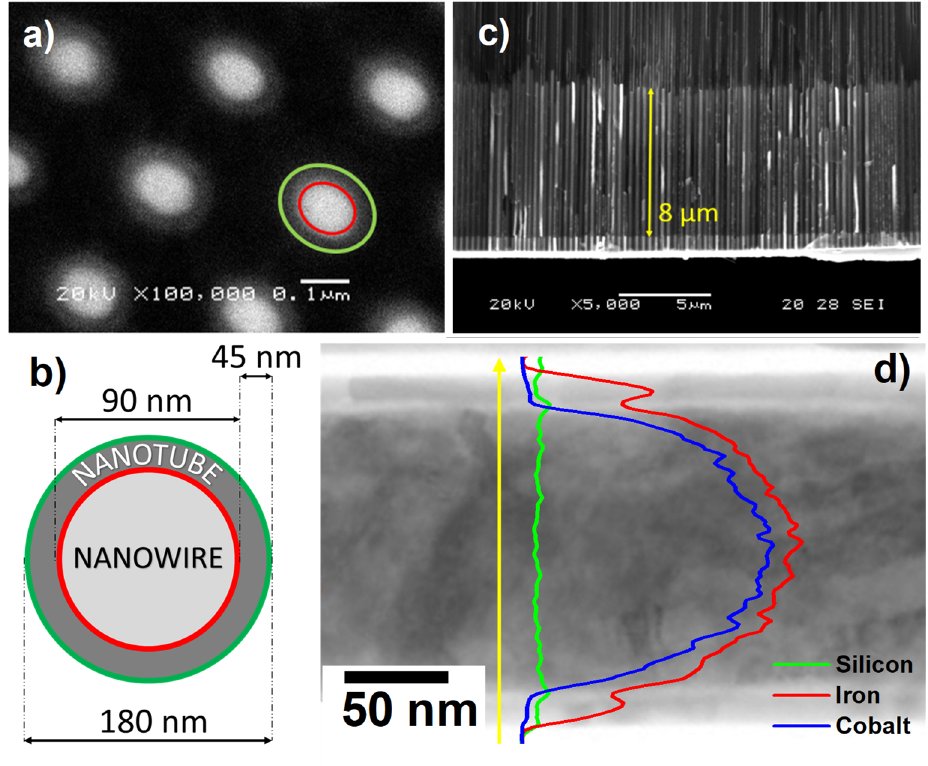
Figure 2. ( a ) Top-view scanning electron micrography of the nanowire/nanotube core/shell system. ( b ) Scheme of the dimensions of the core/shell elements grown in this work. ( c ) Cross-sectional view scanning electron micrography of the nanowire/nanotube system and the mean length of the elements. ( d ) STEM image and EDX linescan analysis performed of a single core/shell NW showing its layered heterostructure.